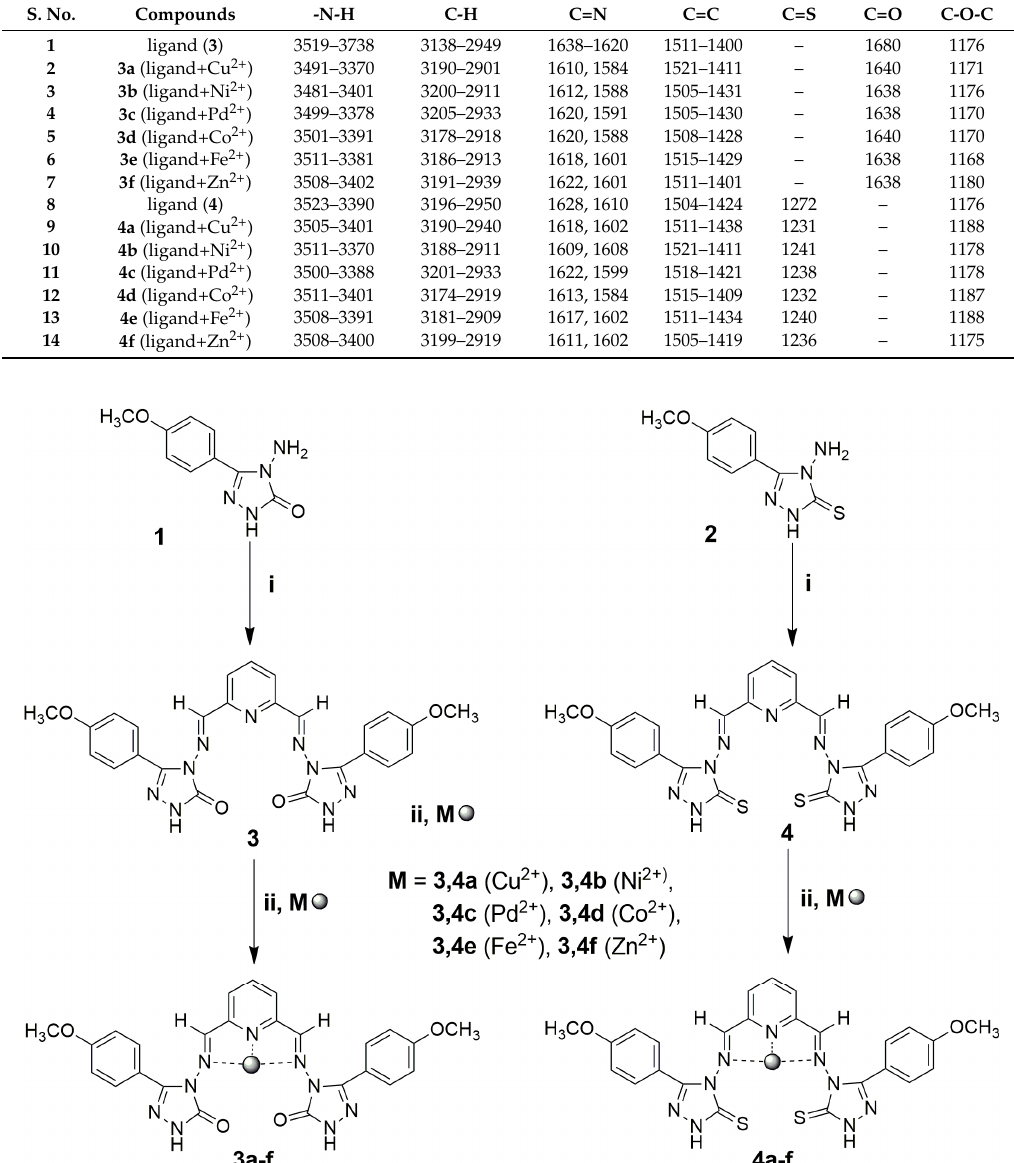
Table 1. FT-IR spectroscopic data for ligands 3 and 4 before and after complexation. S. No.